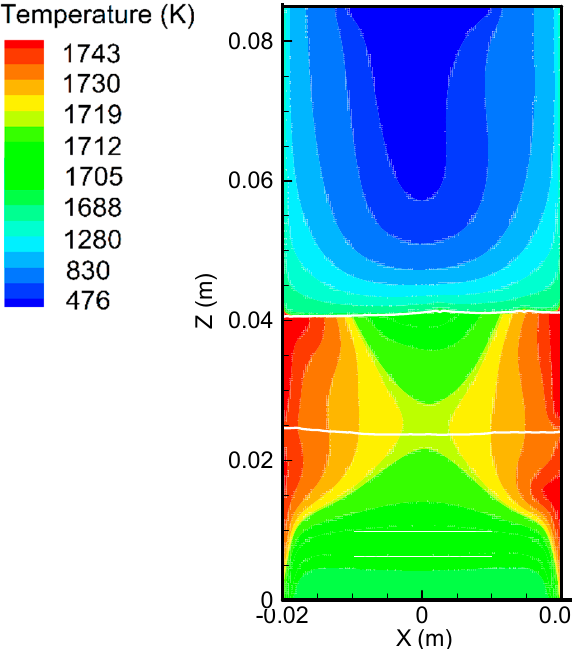
Figure 6. Distribution of temperature at 600 s with the 1873 K heating temperature, and the two white lines are the interfaces between the argon gas and the molten slag, and the molten slag and the molten manganese, respectively.